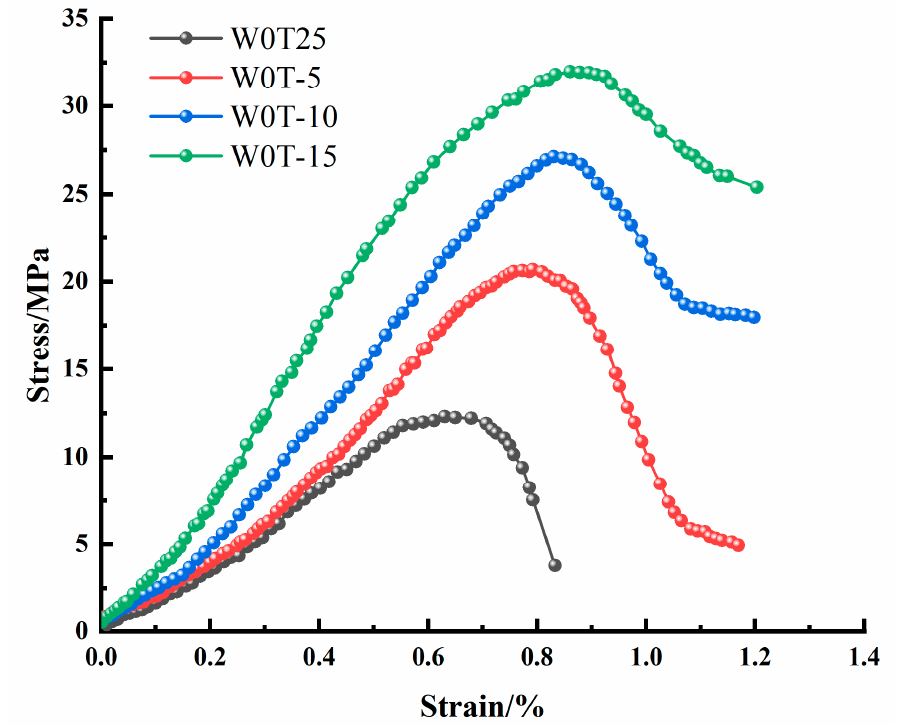
Figure 4. Stress–strain curve of red sandstone under uniaxial compression. The stress–strain curves of red sandstone under triaxial compression at different negative temperatures are provided in Figure 5, and the red sandstone sample under triaxial compression at room temperature was considered the control group. It was evident that under different temperature conditions, the stress–strain curve of red sandstone under triaxial compression was essentially consistent with that under uniaxial compression, conforming to the typical stress–strain curve of rock. Figure 4a demonstrates that at room temperature, with the increase in the confining pressure, the elastic modulus and peak strength were improved. The rock did not have residual strength after the peak strength point, but exhibited a sudden change in the strength, causing rock failure. Under the condition of negative temperature, the triaxial compression strength of sandstone increased with the raise in the confining pressure. Furthermore, with the raise in the confining pressure and the decrease in the temperature, the length of the compaction section decreased. This was because the increase in the confining pressure limited the compression effect of the pores. With the decrease in the temperature, the content of unfrozen water in the rock decreased, and the water in the pores condensed into ice, reducing the pores in the